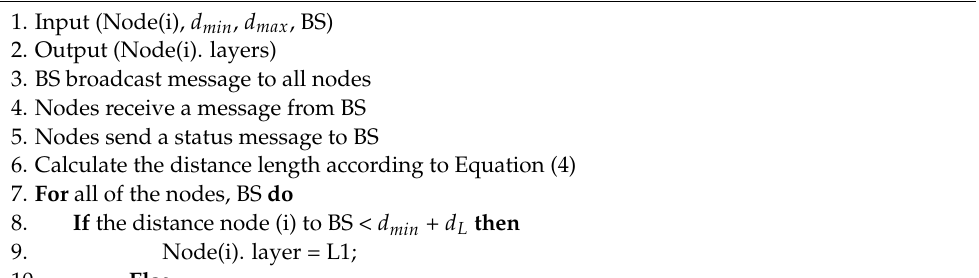
Algorithm 1 The Clustering Layers of